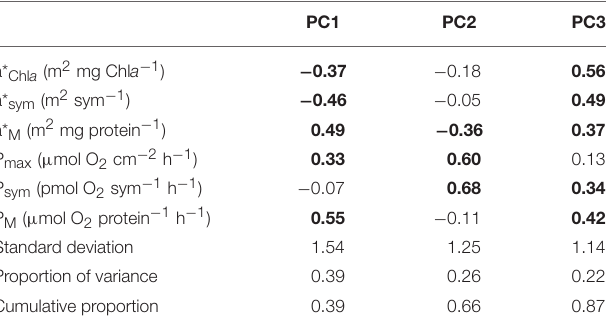
TABLE 3 | PCA analysis for the optical and photo-physiological coral descriptors of the un- stressed, stressed and bleached samples of Orbicella annularis, O. faveolata, Montastraea cavernosa, and Pseudodiploria strigosa